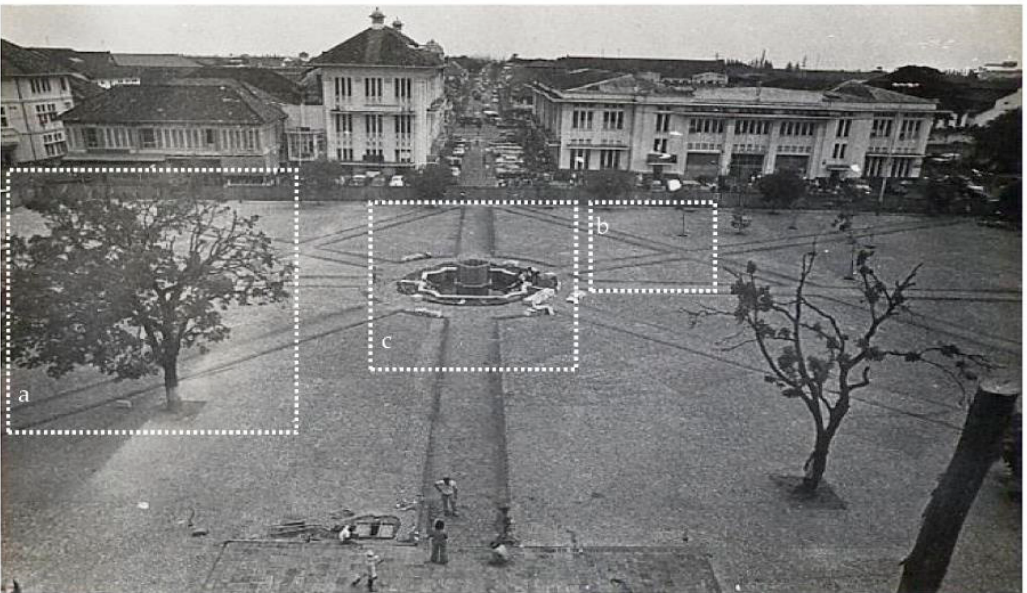
Figure 16. The reconstruction of Water Fountain in the centre of Fatahillah Square. Identified sound